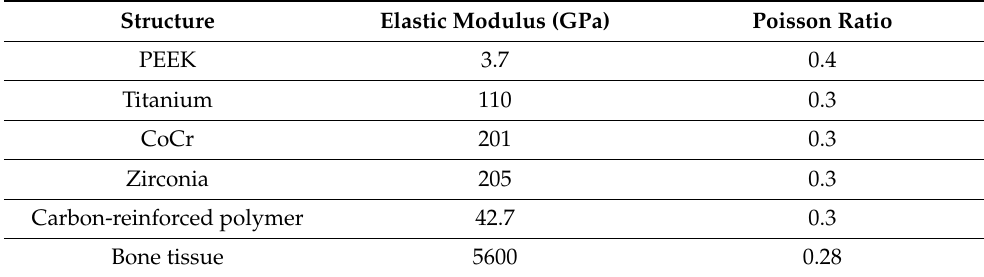
Table 1. Mechanical properties simulated.